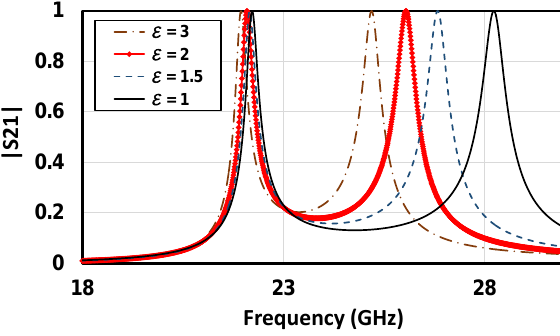
Fig.5. Effect of permittivity change from 1-3, on magnitude of transmission